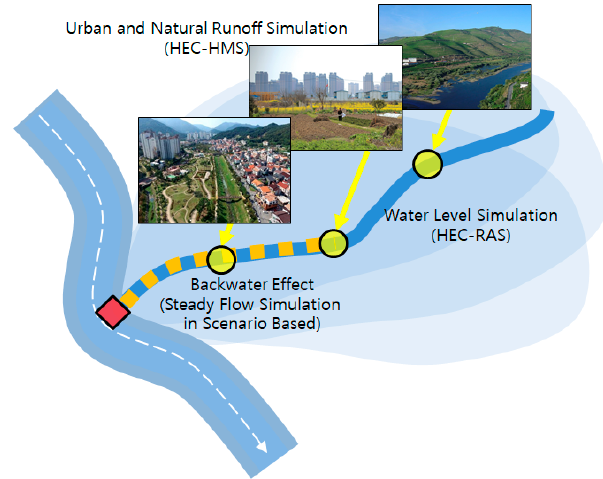
Figure 1. Hydraulic and hydrologic analysis using the Hydrologic Engineering Center’s Hydrologic Modeling System (HEC-HMS) and the HEC’s River Analysis System (HEC-RAS).